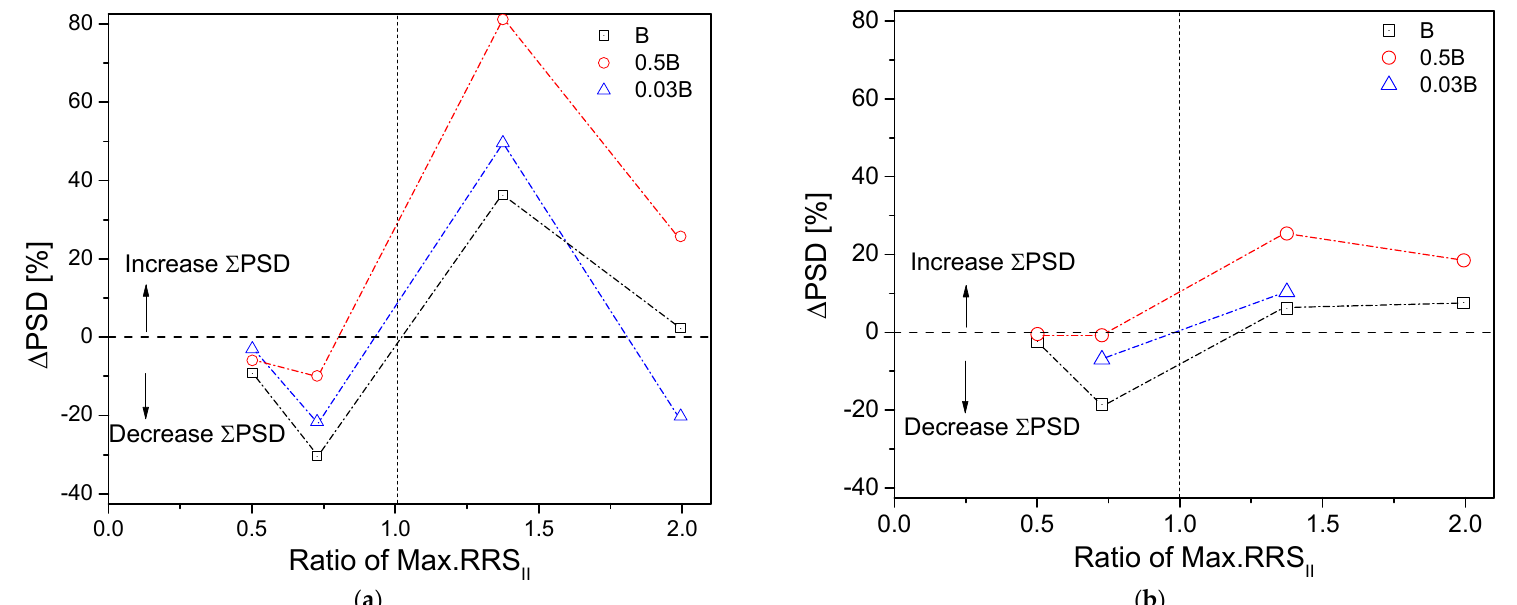
Figure 12. Variation of ΔPSD with ratio of Max.RRS II suffered from artificial earthquake at ( a ) L_Input and ( b ) H_Input.